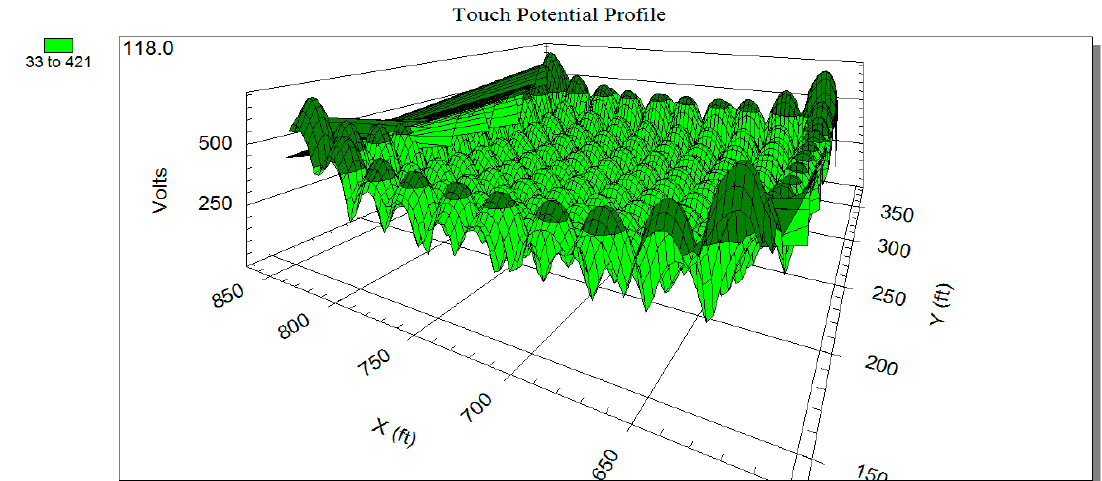
Figure 13. 3D plots of FEM mode touch voltage.